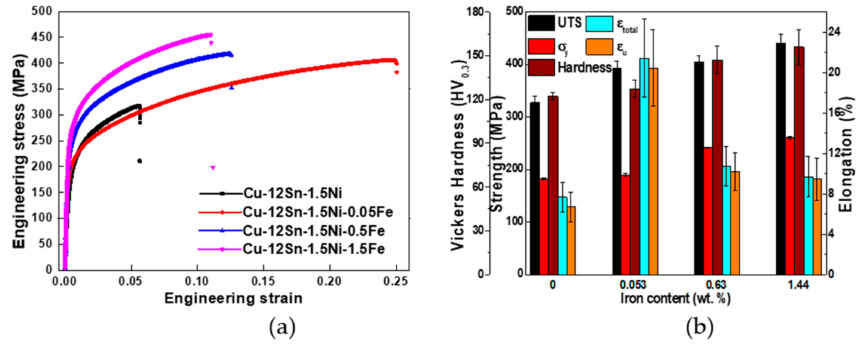
Figure 9. ( a ) Engineering stress vs. strain curves; ( b ) Tensile properties and hardness (HV0.3)